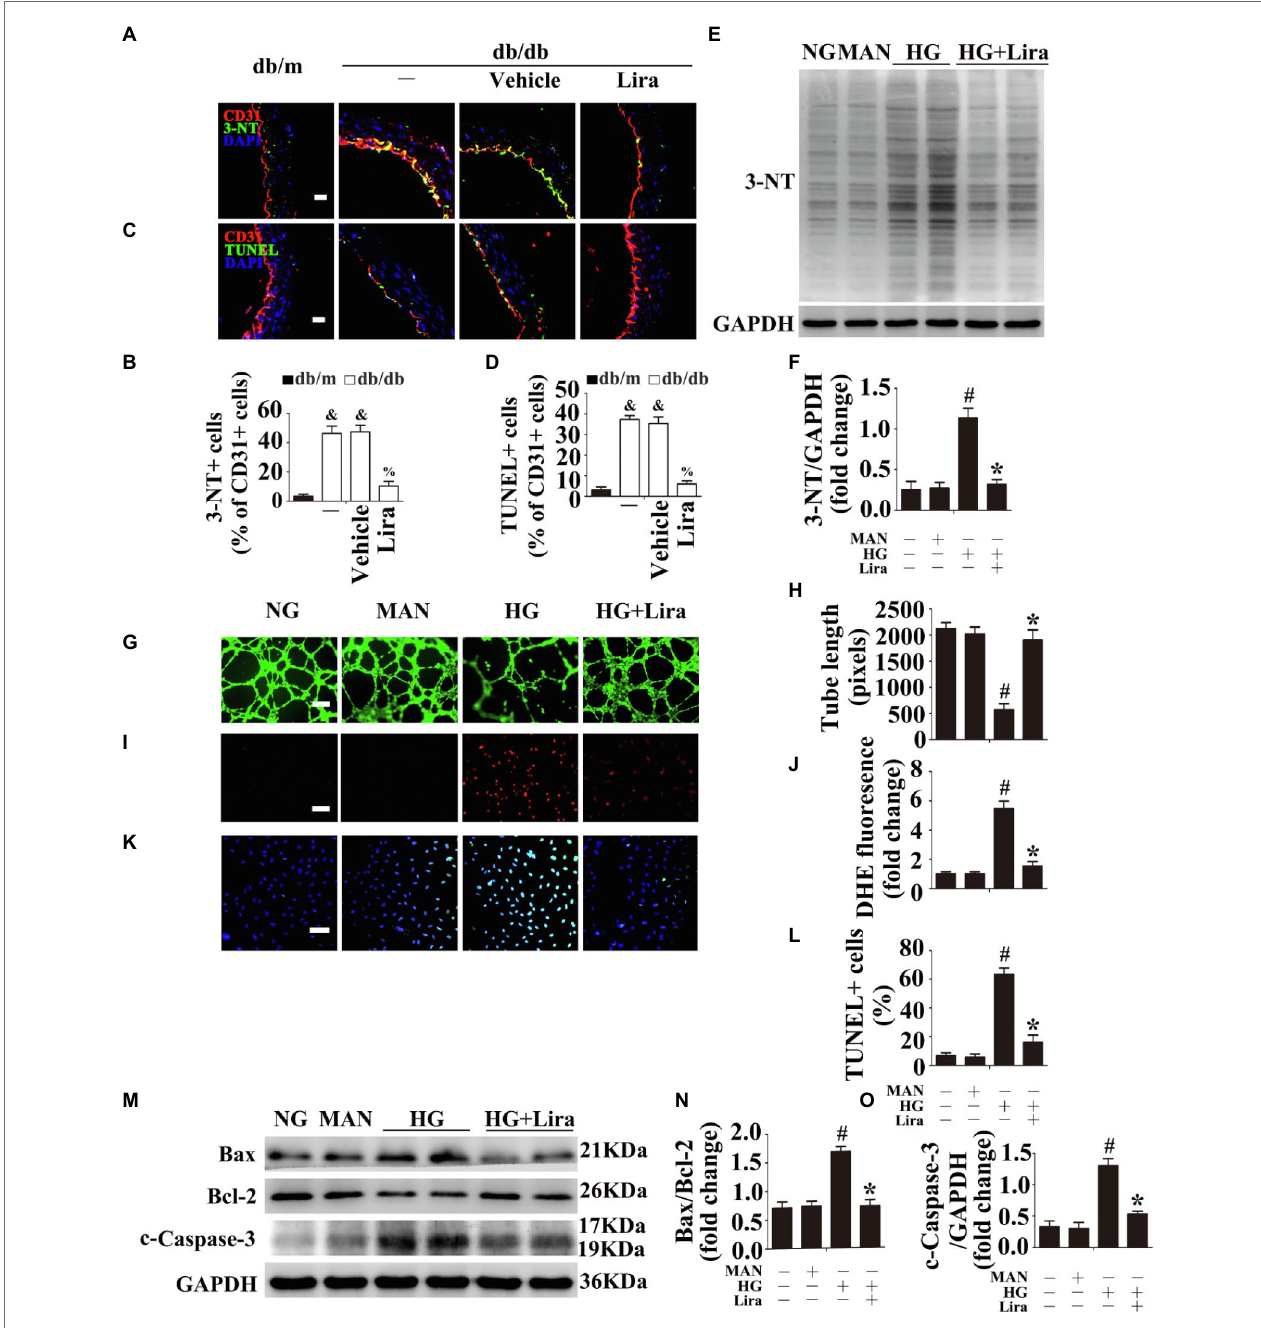
FIGURE 1 | Liraglutide (Lira) attenuates hyperglycemia-induced endothelial dysfunction both in vivo and in vitro . (A) The representative images of immunofluorescence with 3-NT, scale bars = 20 μ m and (C) endothelial cells TUNEL assay, scale bars = 20 μ m, from db/m mice, db/db mice, and db/db mice receiving Lira (200 μ g/kg/day) or vehicle treatment with saline infusion aorta tissue sections. (B) Quantification of the proportions of 3-NT positive cells and (D) TUNEL-positive cells of CD31+ cells. (E) Cell lysates of human umbilical vein endothelial cells (HUVECs) were used to detect the 3-NT protein levels by immunoblotting. HUVECs cultured in different mediums containing normal glucose (NG; 5.5 mM), high glucose (HG; 33 mM) alone or with Lira (100 nM) for 72 h, and mannitol (MAN; 33 mM: 5.5 mM of glucose + 27.5 mM of D-mannitol) served as the osmotic control for the HG. (F) The quantitative analysis of the immunoblots. (G) Capillary-like tube formation, scale bars = 300 mm. (I) Fluorescence with DHE, scale bars = 100 mm and (K) TUNEL assay, scale bars = 100 mm, HUVECs were treated as indicated in (E) . (H) Quantification of the tube length, (J) the DHE fluorescence intensity ratio, and (L) the quantitative analysis of TUNEL cells. (M) Cell lysates of HUVECs were used to detect the Bax, Bcl-2, and c-Caspase-3 protein levels by immunoblotting. HUVECs treated as indicated in (E) . (N,O) The quantitative analysis of each immunoblot. All values displayed are means ± SEM of five independent experiments. & p < 0.05 vs. db/m mice; % p < 0.05 vs. db/db mice or vehicle treated db/db mice. # p < 0.05 vs. NG or MAN; and * p < 0.05 vs.